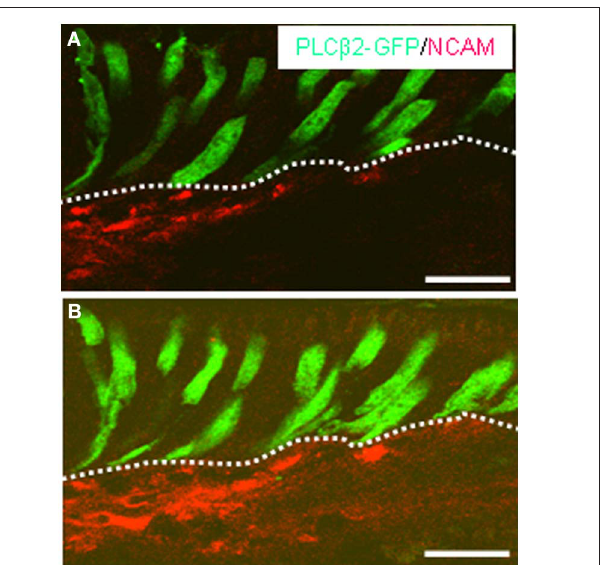
FIGURE 6 | NCAM-immunostaining displays the distribution of nerve fibers in close vicinity to GFP-expressing cells. (A,B) Projections of confocal image stacks of cross sections through the corpus mucosa of PLC β 2 promoter-GFP transgenic mice. Immunostaining with NCAM antibody ( red ) indicates the trajectory of a dense fiber bundle meshwork near the basolateral pole of the GFP-immunoreactive ( green ) cells. The cluster of elongated GFP-positive cells are located in the most apical cell layer (bordered by the white dotted line ) contacting with their apical processes the lumen of the groove built by the “limiting ridge.” In direct vicinity to the GFP-expressing cell cluster NCAM-positive fibers can be observed. Note the long basolateral process of these cells apparently extending toward the stained fibers. Scale bars : (A,B) = 20 μ